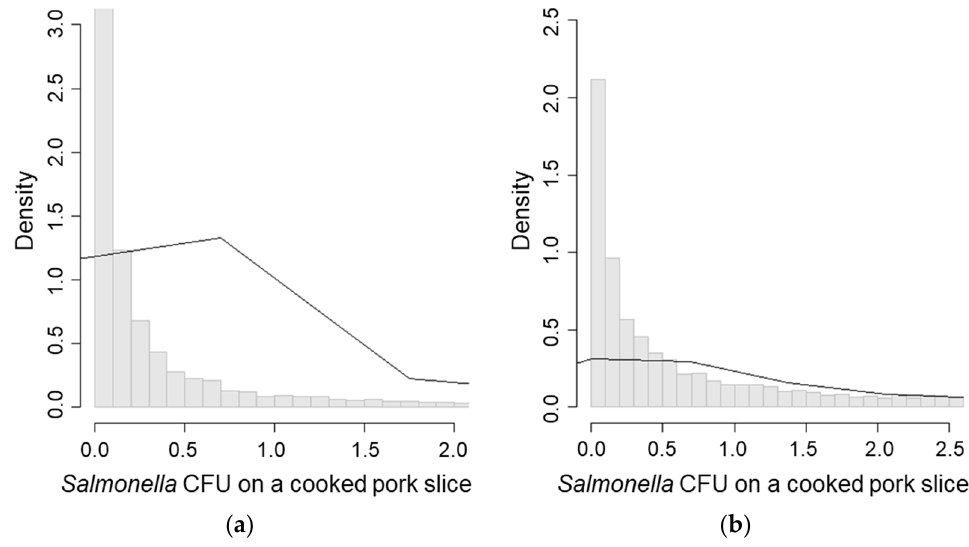
Figure 6. Worst case scenarios of Salmonella CFU/g on a pork slice due to cross-contamination. ( a ) Scenario 1—Washing hands, the knife and the cutting board; ( b ) Scenario 4—Using a new knife,